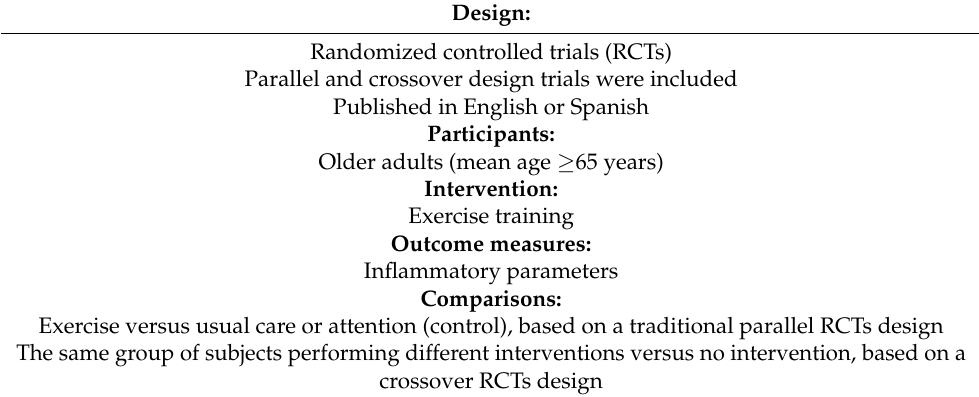
Table 1. Inclusion